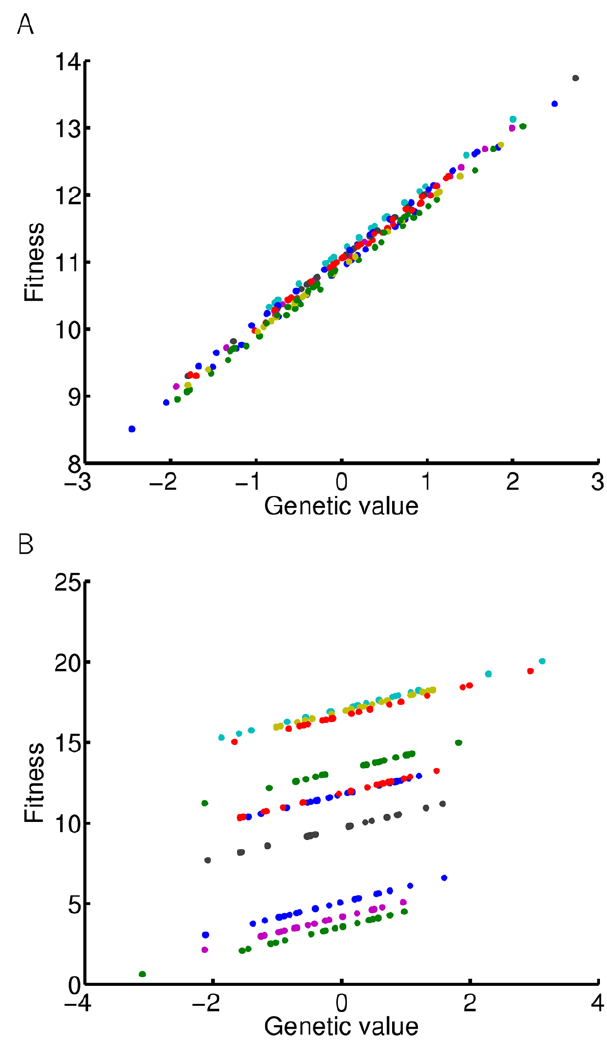
Figure 7. Inter and intragroup variance in fitness. Simulations of 10 groups of 20 interacting individuals; a given trait in a focal individual affects the same trait in other individuals (shown in Figure 1 C). Different colours represent individuals in different groups. (A) The value of Y 11 ~ 0 : 02 . Within group variance is high, but between group variance is low. (B) The value of Y 11 ~ 0 : 05 . Within group variance is low, but between group variance is high.